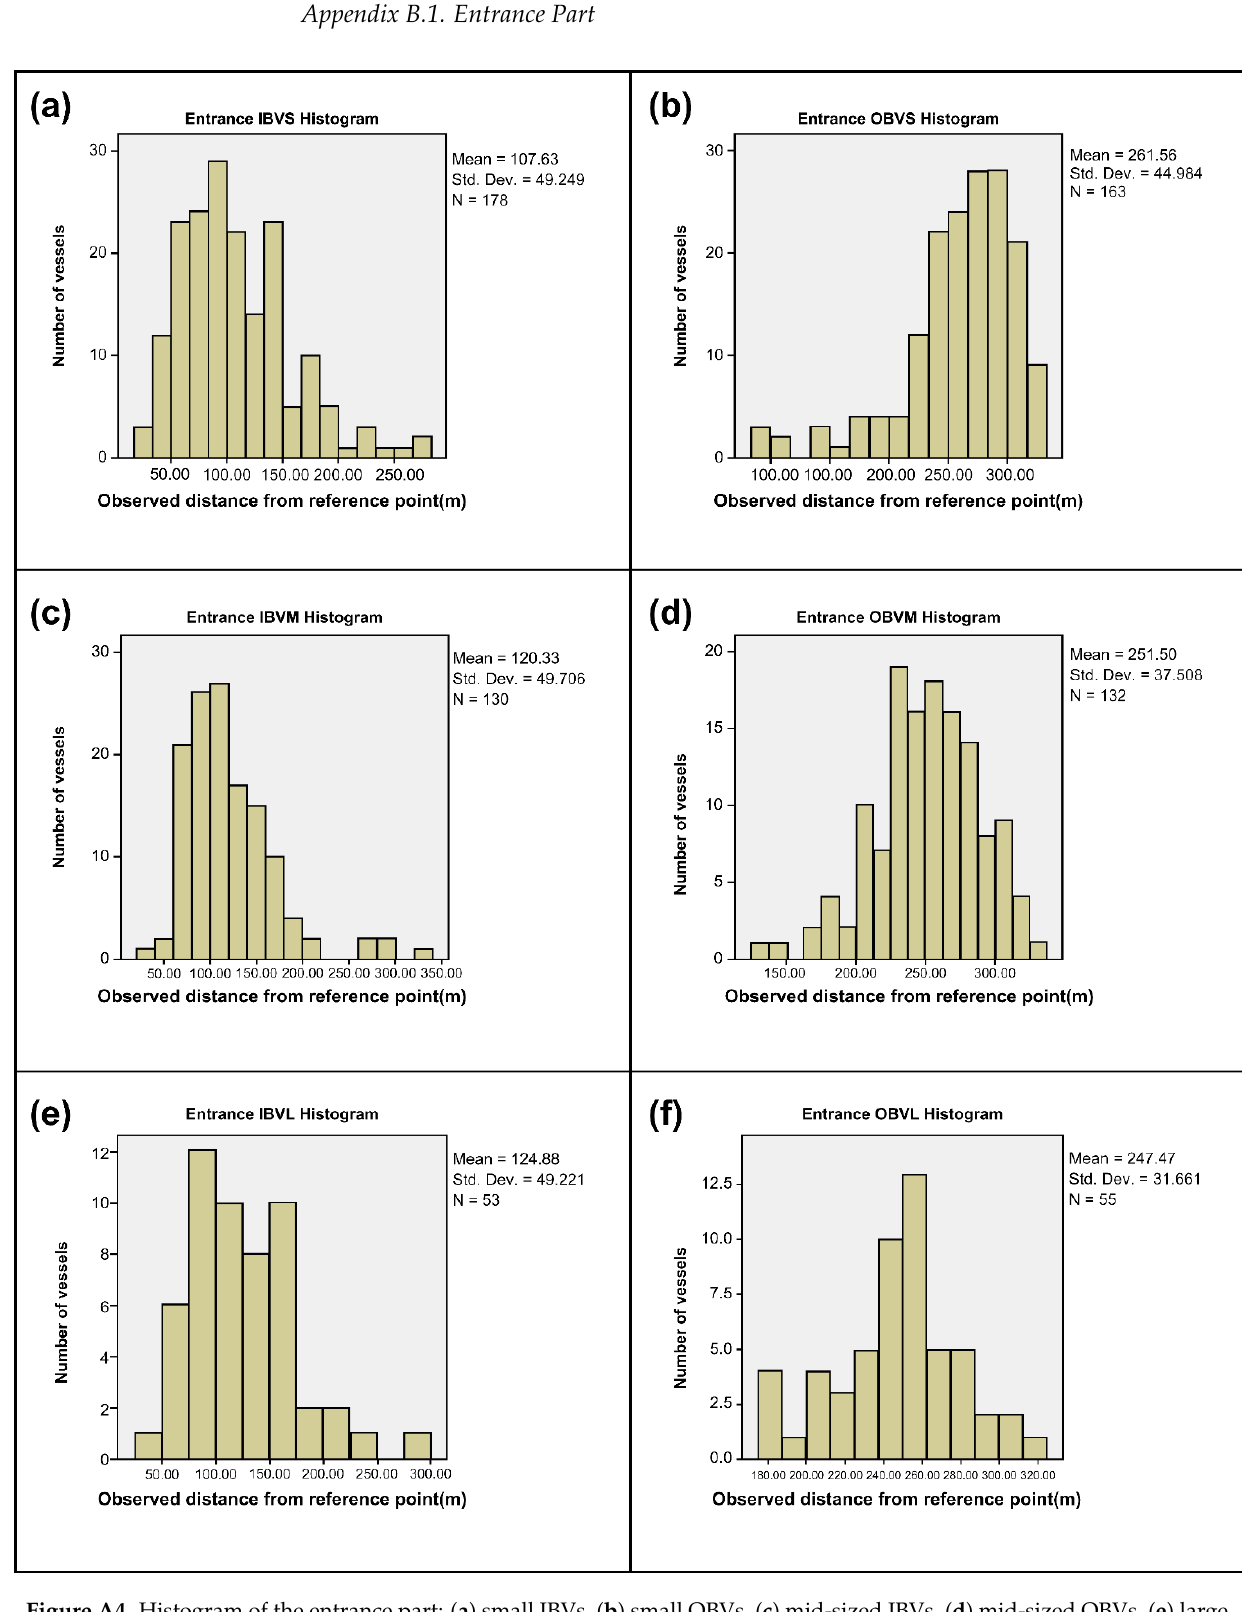
Figure A4. Histogram of the entrance part: ( a ) small IBVs, ( b ) small OBVs, ( c ) mid-sized IBVs, ( d ) mid-sized OBVs, ( e ) large IBVs, and ( f ) large OBVs.